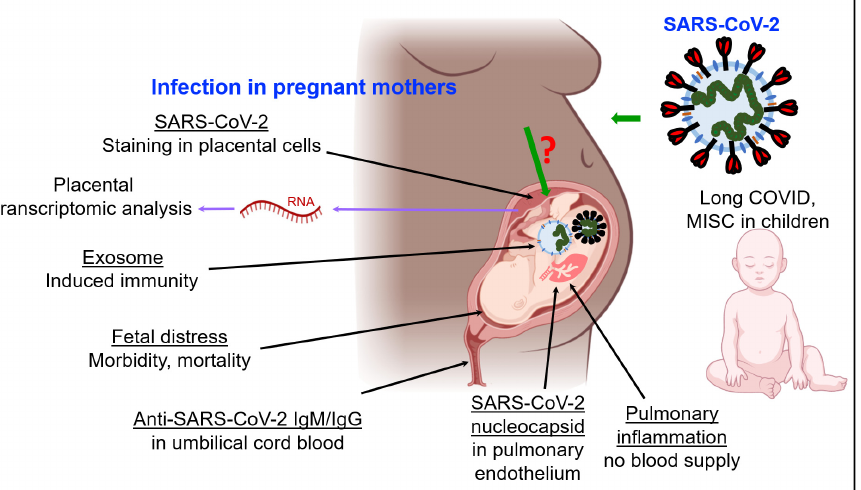
Figure 1. Reported impacts of SARS-CoV-2 infection on fetuses through pregnant mothers, and on children. Abbreviations: MISC multisystem inflammatory syndrome in children. “?” indicates that transmission mechanism is not clearly understood.